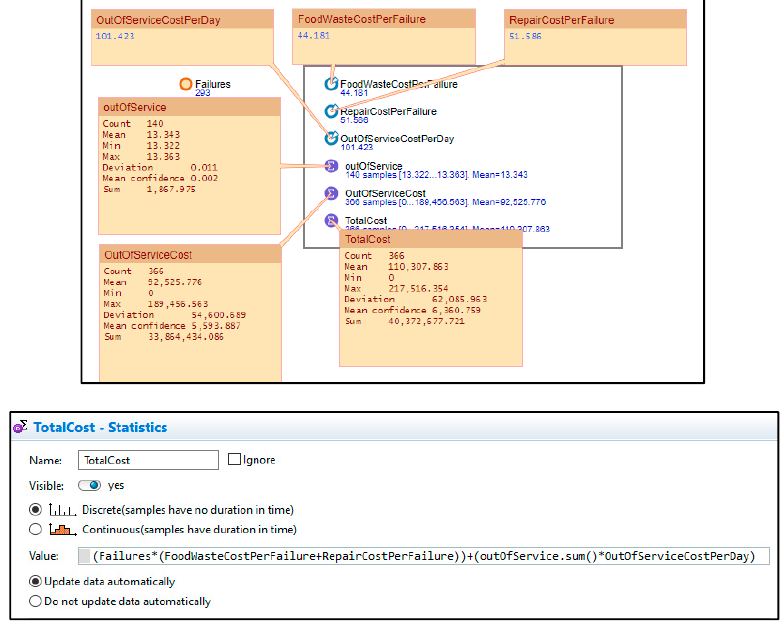
Figure 11. Model